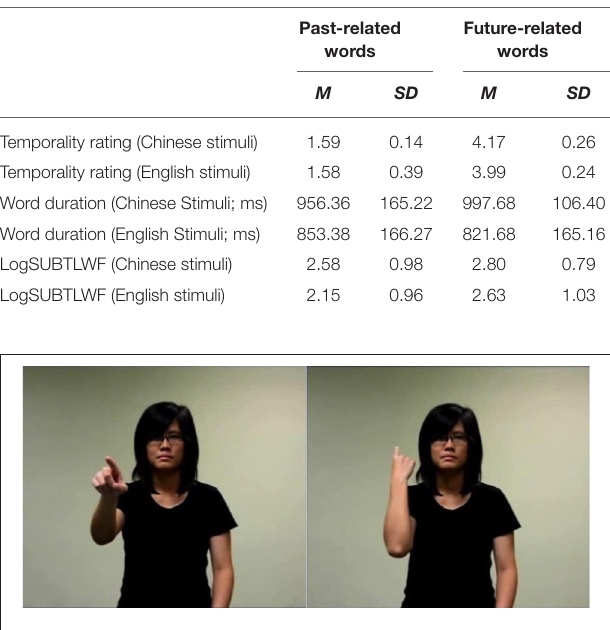
FIGURE 2 | Snapshot of the forward-pointing and backward-point gestures. The individual in the picture above is that of a research assistant employed by our lab and consent was obtained from this individual for the publication of the